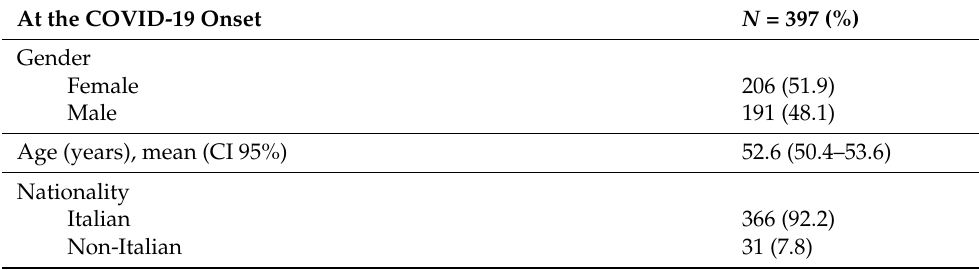
Table 1. Characteristics of the interviewed